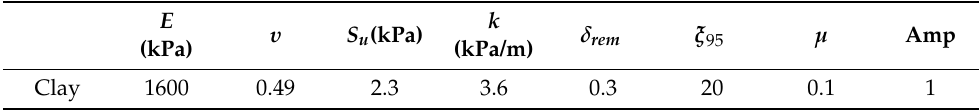
Table 3. Material properties of soil in the TBSR–VUMAT